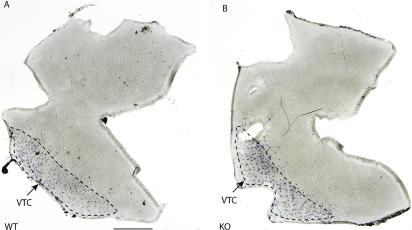
The Region of Origin of Ipsilaterally Projecting Retinal Ganglion Cells Is Not Altered in Ten_m3 KO MiceWhole-mount retinas following reaction for WGA-HRP retrogradely transported from the ipsilateral dLGN nucleus. Labelled cells are present in similar numbers (see text) within the same region of retina and the VTC in both WT (A) and KO (B) mice. Scale bar indicates1 mm, which applies to both images.